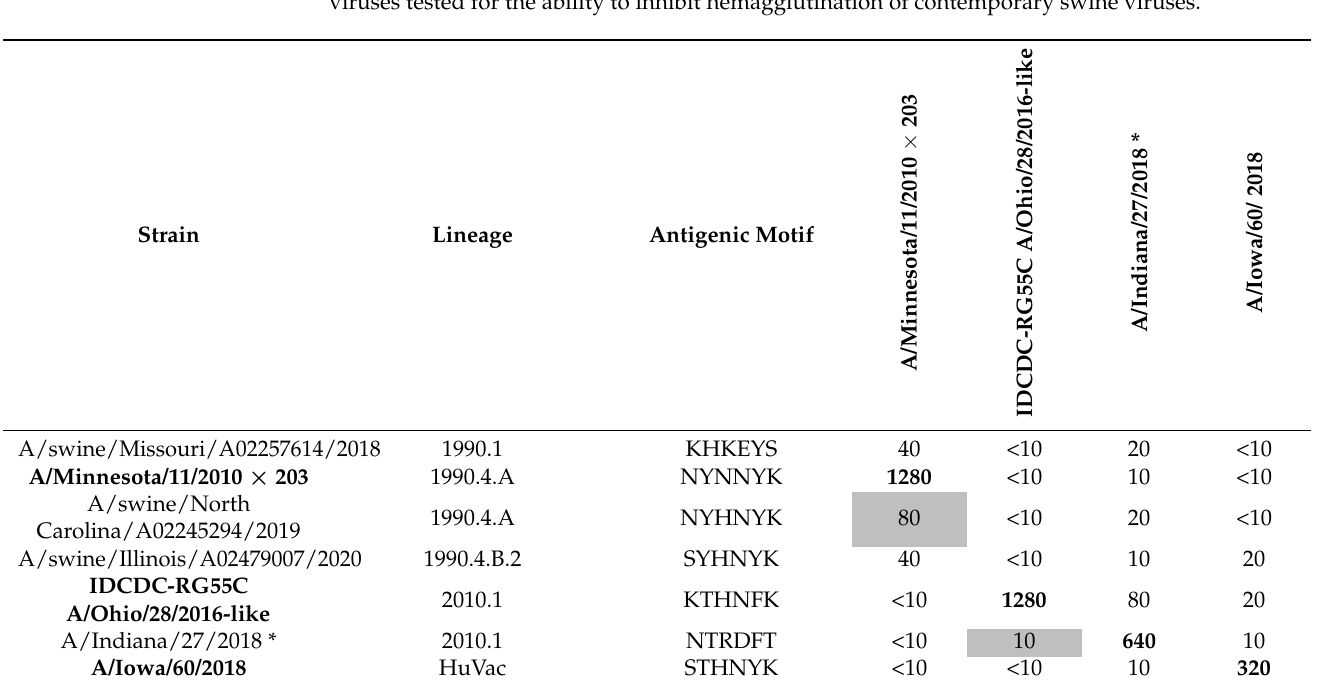
Table 2. Hemagglutination inhibition assays with ferret antisera raised against CVV and vaccine viruses tested for the ability to inhibit hemagglutination of contemporary swine